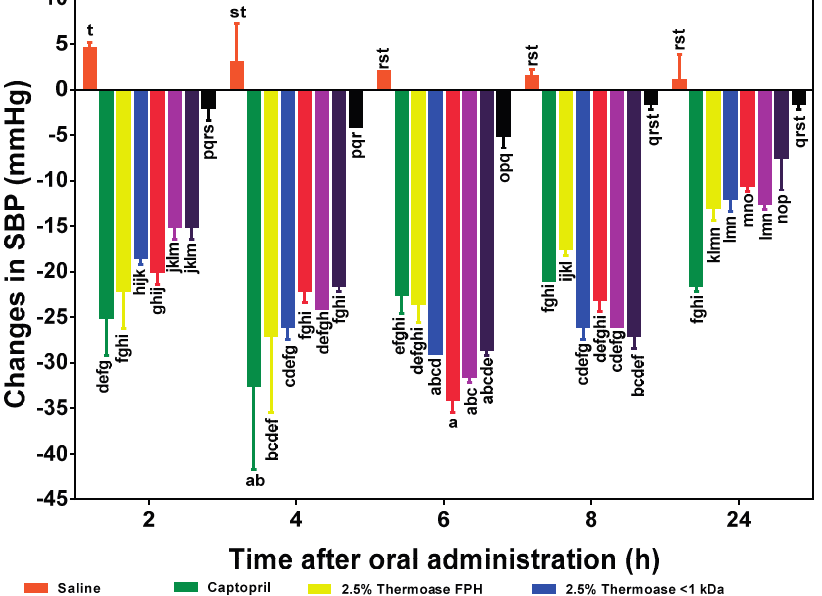
Figure 6. Effects of 2.5% enzymatic flaxseed protein hydrolysate (FPH), membrane ultrafiltration peptide fractions and flaxseed protein isolate (FPI) on systolic blood pressure (SBP) of spontaneously hypertensive rats (SHR) after oral gavage. Rats were administered with FPH, FPH fractions and FPI using a dose of 200 mg protein/kg rat body weight (BW) while the positive control, captopril was given at 10 mg/kg body weight. Saline was used as the negative control. Bars with different letters have mean SBP values that are significantly ( p < 0.05)